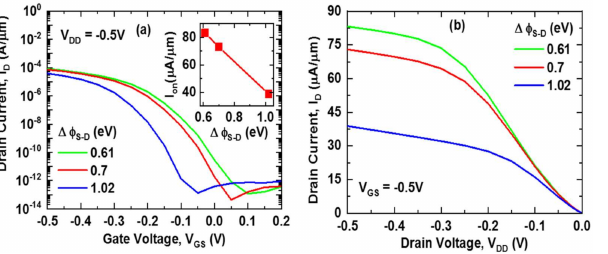
Figure 2. ( a ) Transfer characteristics (I D -V GS ) at V DD = − 0.5 V; inset shows I on as a function of work function difference ( ∆ φ S-D ) and ( b ) output characteristics (I D -V DD ) at V GS = − 0.5